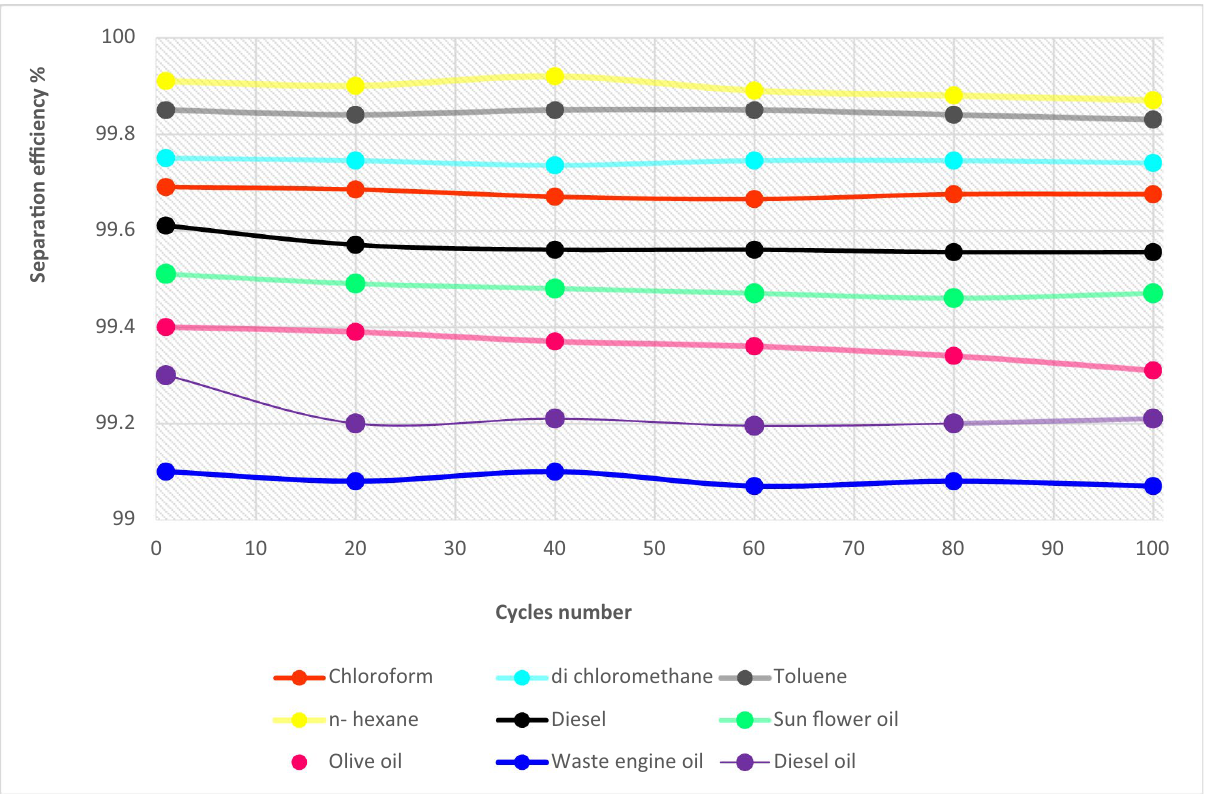
Figure 6. Separation efficiency of modified cellulosic FP membranes for different oils and